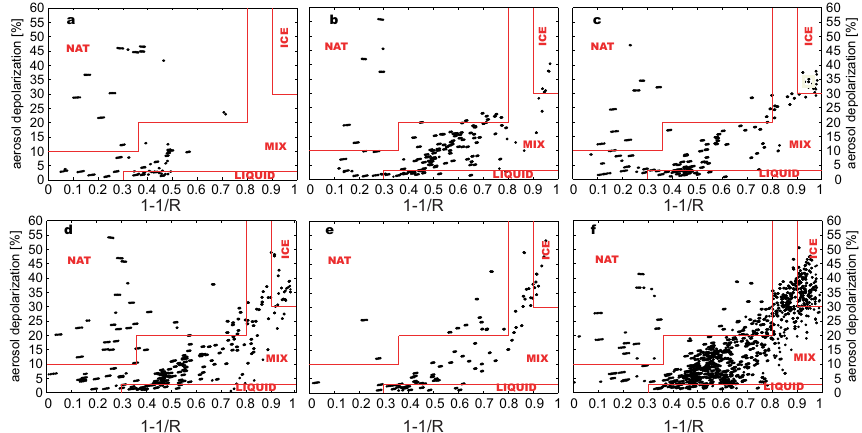
Fig. 4. PSCs detected by CALIPSO classified according to Massoli et al. (2006) with respect to the type of the underlying tropospheric cloud system: cirrus (a) , mid-tropospheric clouds (b) , and an absence of tropospheric clouds (c) . Deep-tropospheric clouds were further distinguished with respect to the overlap between the PSC and the tropospheric cloud layer: PSC had the same (d) or a larger spatial extent (e) as the underlying deep-tropospheric clouds or the PSC was observed over a mixture of deep-tropospheric clouds and mid-tropospheric clouds (f) . One dot represents one height bin (60 m vertical resolution, 180 m smoothing length ) of a CALIPSO